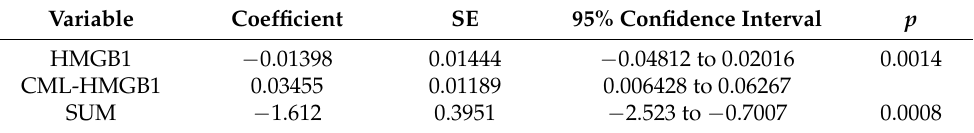
Table 2. Multivariate analysis of HMGB1, CML-HMGB1, and the sum for drug resistance. Variable Coefficient SE 95% Confidence Interval p